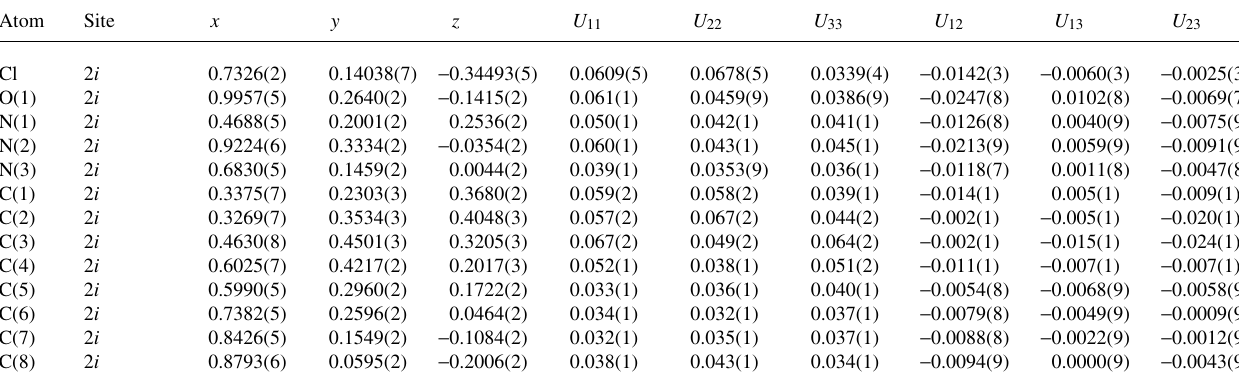
Table 3. Atomic coordinates and displacement parameters (in Å 2 )